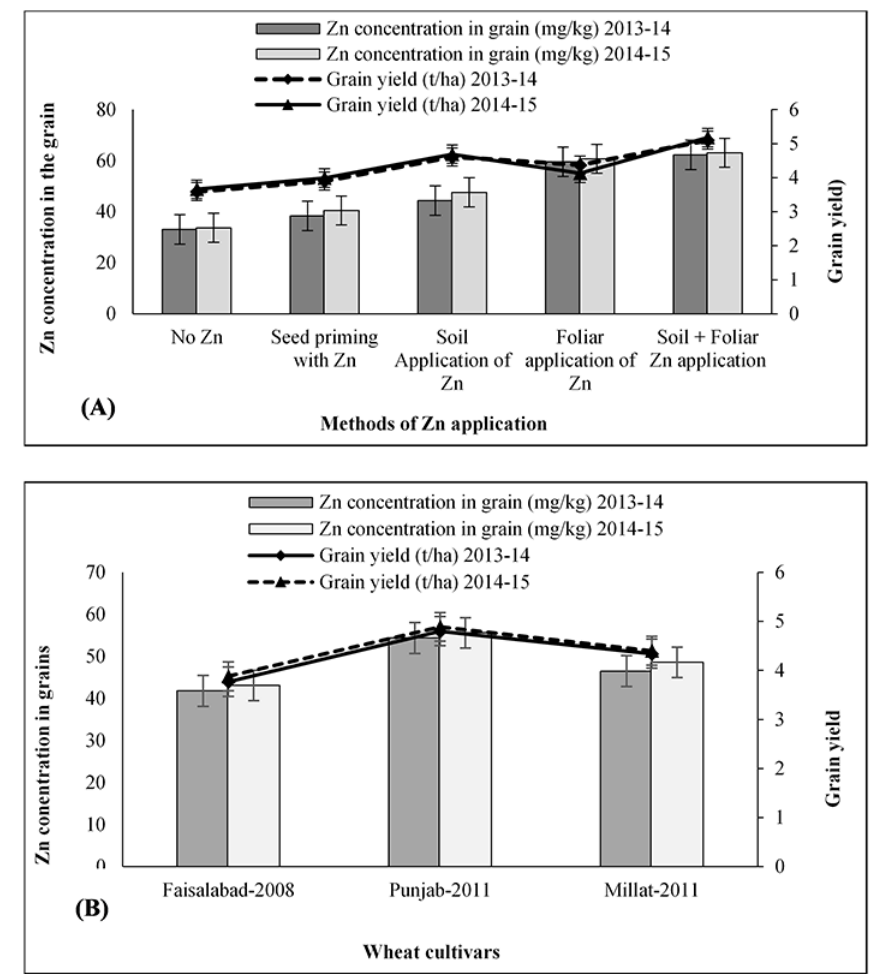
Fig. 2 Zn concentrations in the grains of wheat as influenced by Zn application methods ( A ) and by wheat cultivar ( B ) (source: